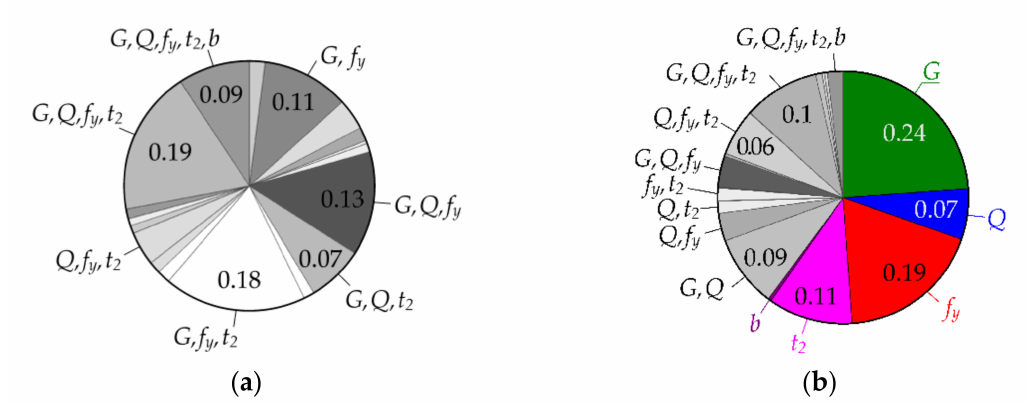
Figure 13. The results of SA for P f = 8.5 × 10 − 6 using: ( a ) P4 M ( P f ), Equation (27); ( b ) L M ( P f ), Equation (28).